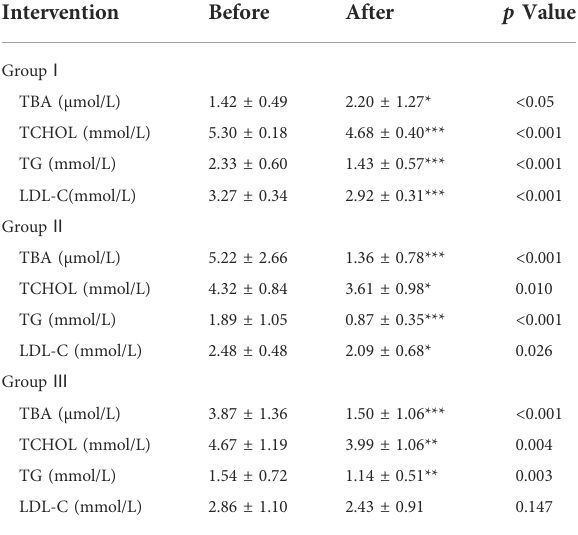
TABLE 2 Comparison the level of serum biochemical indexes of different groups. Intervention Before After p